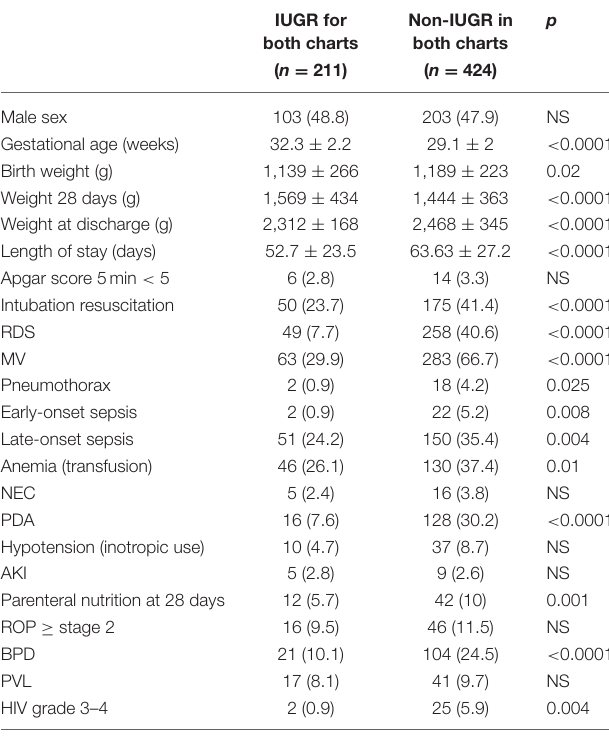
TABLE 3 | Comparison of neonatal morbidity in IUGR and non-IUGR patients for both charts.